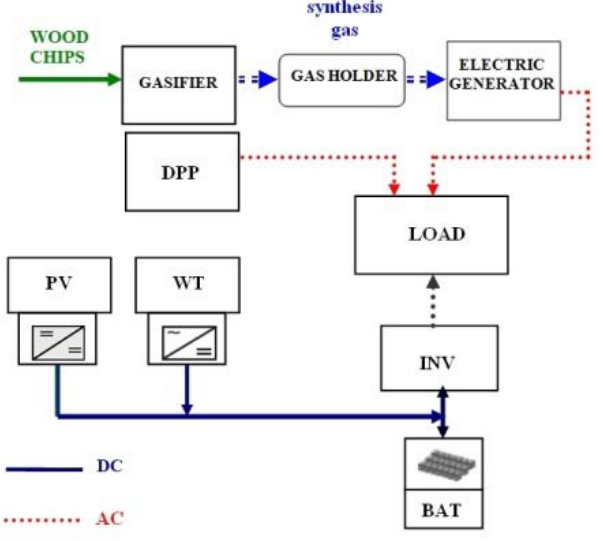
Figure 3. The structural diagram of the power supply system.